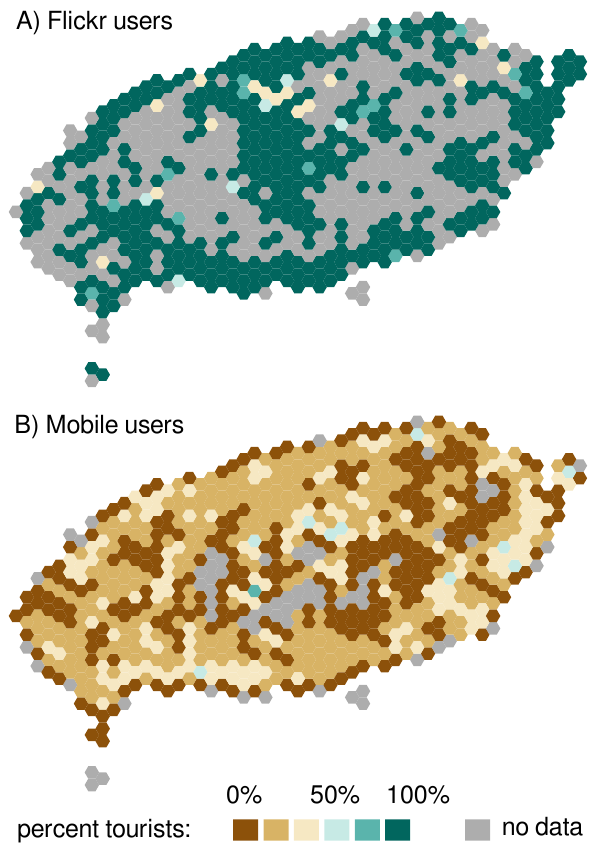
Figure 4. Maps show the percentage of visitors who are tourists, based on data from ( A ) Flickr profiles and ( B ) mobile-phone communications, summarized in 2.6 km 2 hexagonal cells. Greens indicate majority tourists, browns indicate majority Jeju residents. All tweets were assumed to originate from tourists and thus not plotted